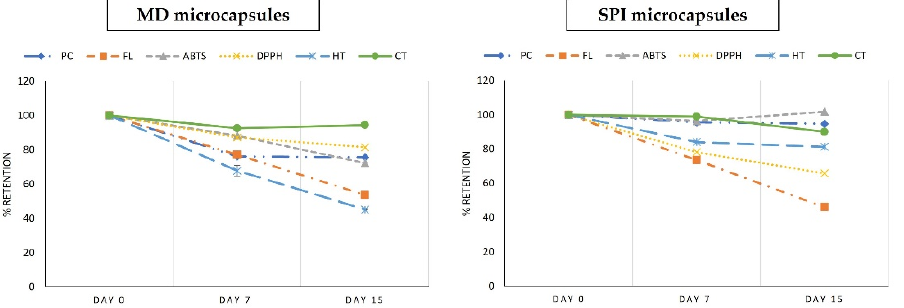
Figure 7. Retention (%) based on day 0 of bioactive compounds (PC, FL, AC (ABTS and DPPH), HT, CT) in yogurt added with muicle extract MD and SPI microcapsules.